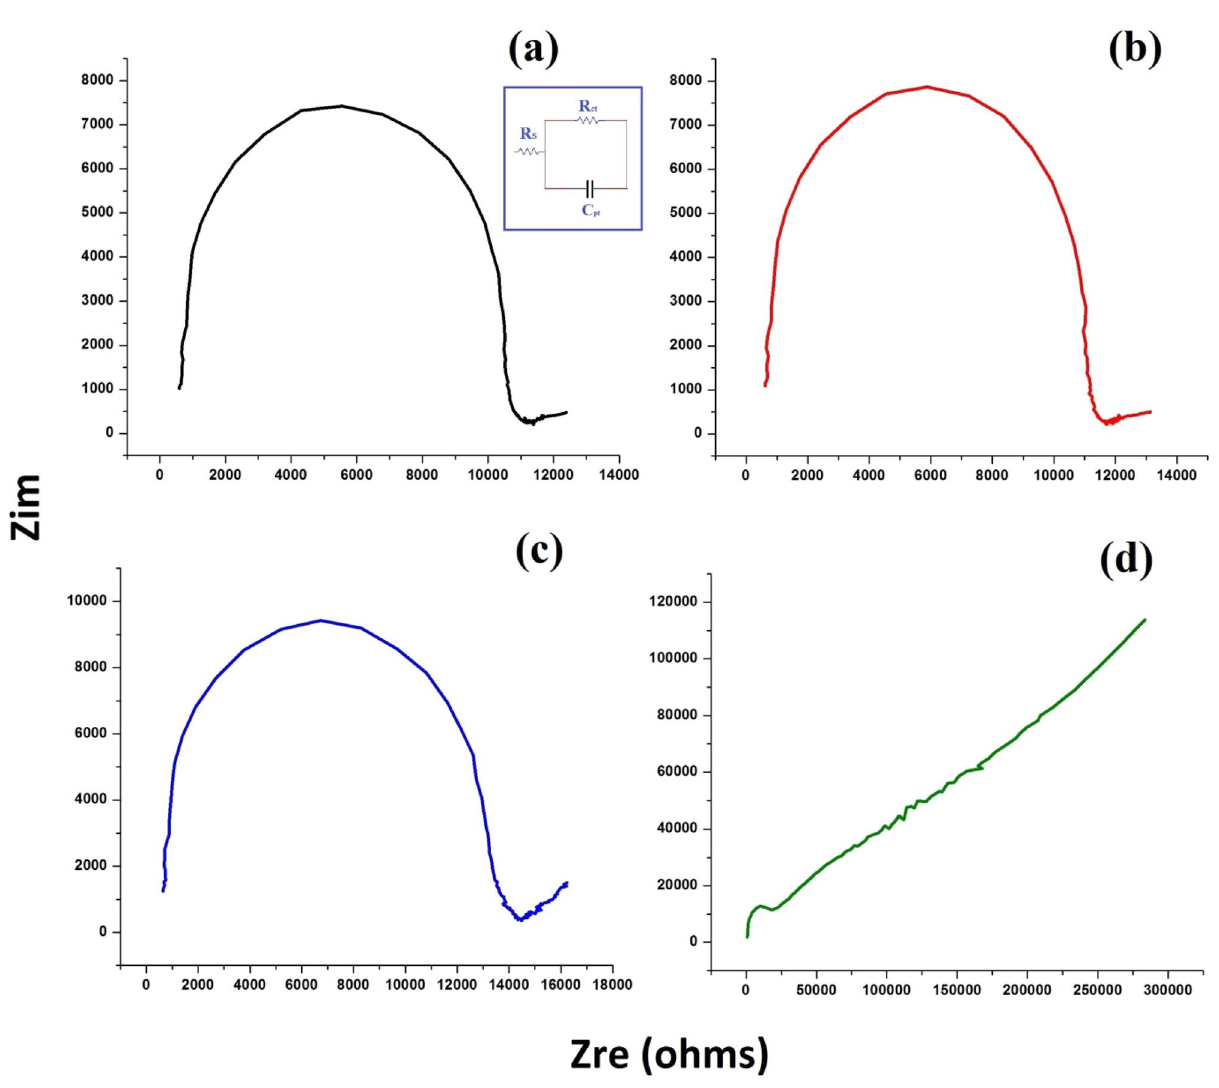
Fig. 9 Nyquist plot for Cd